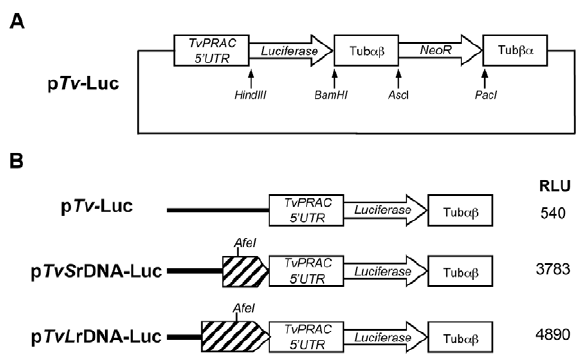
Figure 4. Trypanosoma vivax -specific luciferase vectors. Sche- matic representation of p Tv LUC vector constructs (A); Tv PRAC5 9 UTR, upstream of the Tv PRAC region and containing spliced leader acceptor site; Tub ab , intergenic region between alpha and beta tubulin genes; NeoR, neomycin phosphotransferase gene; Tub ba , intergenic region between b and a tubulin genes. Representation of the ribosomal promoter region cloned into p Tv- Luc and associated luminescence in Relative Light Units (RLU) detected in the supernatant 48 h after epimastigote transfection with p TvS rDNA-Luc and p TvL rDNA-Luc (B).